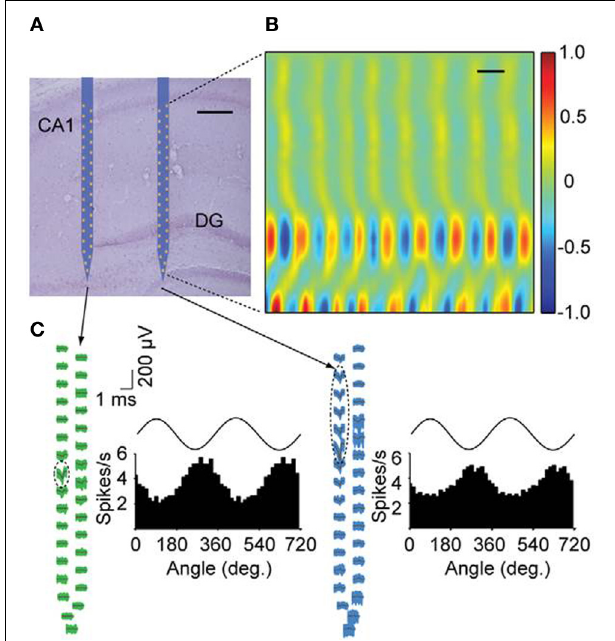
FIGURE 8 | Simultaneous recordings of neurons with nanofabricated probes in awake behaving mice. (A) Nissl-stained brain section overlaid with a schematic of the probe at its stereotaxically implanted location. Each silicon shaft is 60 mm wide. Scale bar, 200 mm. (B) Current source density analysis of local field potentials across the hippocampus with a vertical resolution of 28 mm. DG, dentate gyrus. Neural data was collected during home cage exploratory behavior. Current source density is normalized to ´s 1. Scale bar, 100 ms. (C) Waveforms of two putative single cells recorded with the nano-probe across all sites together with histograms showing theta phase locking of spikes. Dashed ellipses indicate the sites exhibiting the highest extracellular action potentials for these units. Theta oscillations shown on top of the histograms are for reference. Theta oscillations were measured from the upper rightmost electrode near the CA1 pyramidal cell layer (Adapted with permission from Du et al.,